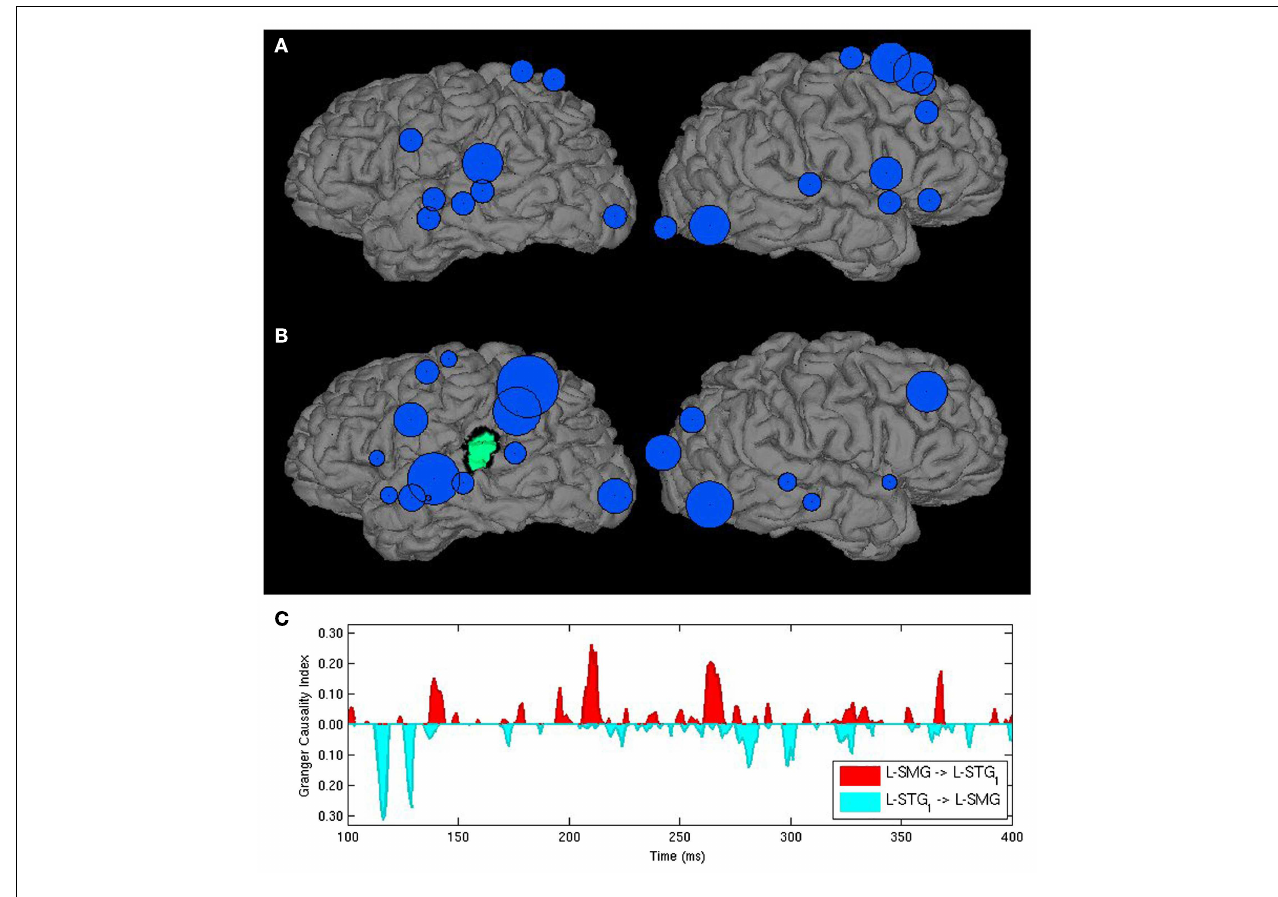
the relative strength of Granger influence (cumulative Granger Causality index values) by ROIs on a target region identified in green. (C) Plots a continuous measure of Granger causation strength for afferent (red) and efferent (teal) interactions between the left STG and SMG from 100 to